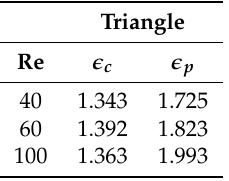
Table A4. Normalized mass transfer and normalized pressure drop for triangular spacer-filled channels at different temperatures with respect to the corresponding values for flat